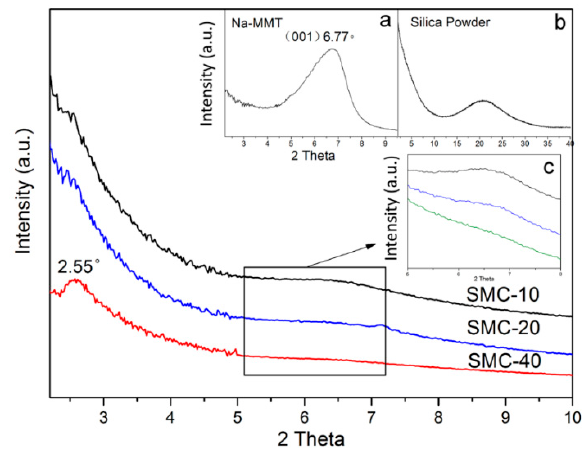
Figure 2. X-ray diffraction (XRD) patterns of MMT, silica and silica/MMT